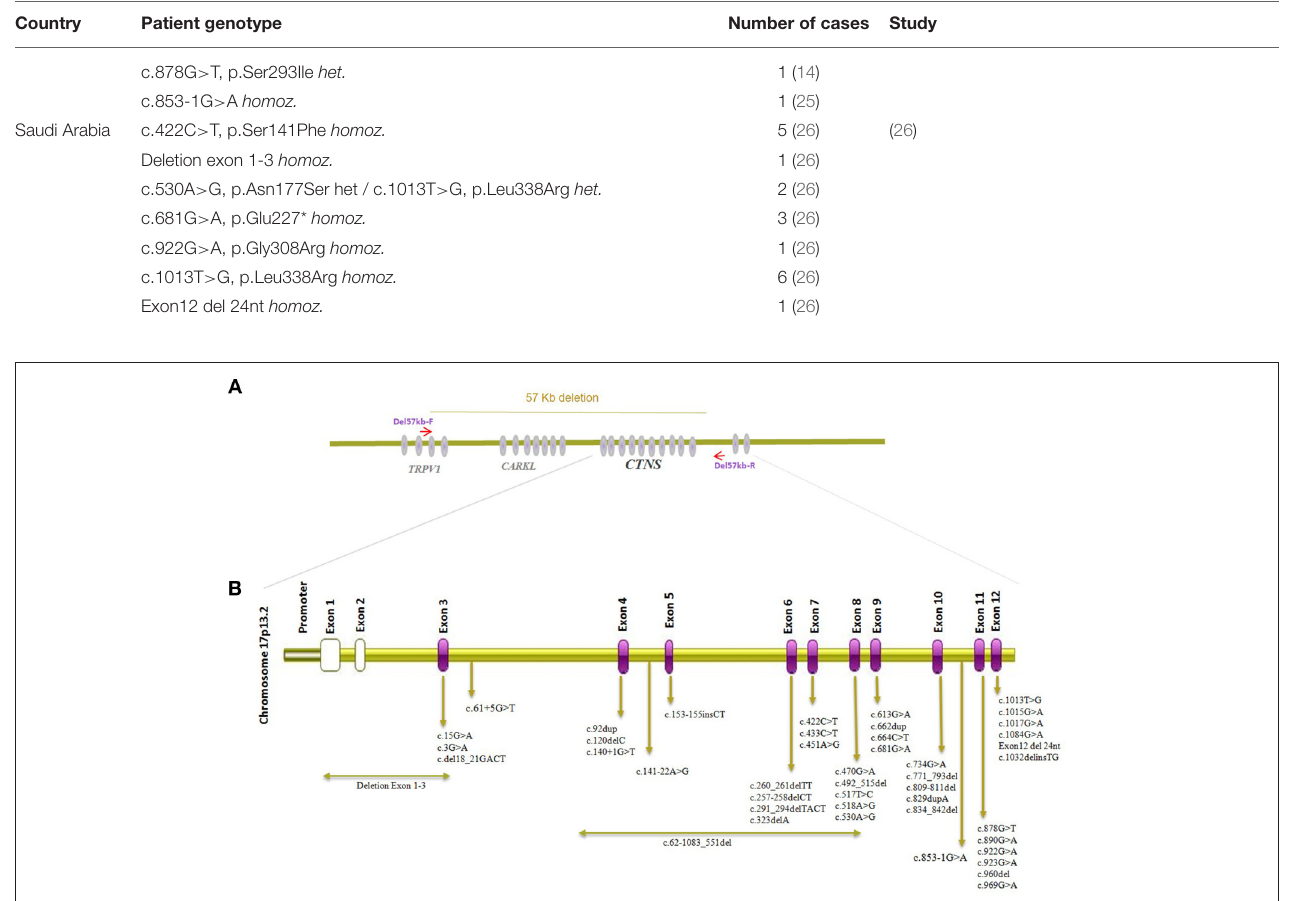
FIGURE 2 | CTNS gene structure and visualization of alleles detected in individuals of Middle-Eastern ethnical origin. (A) Visualization of the genomic location of CTNS and genomic breakpoints of the 57kb deletion. (B) Localizations of CTNS alleles described in cystinosis patients from the Middle